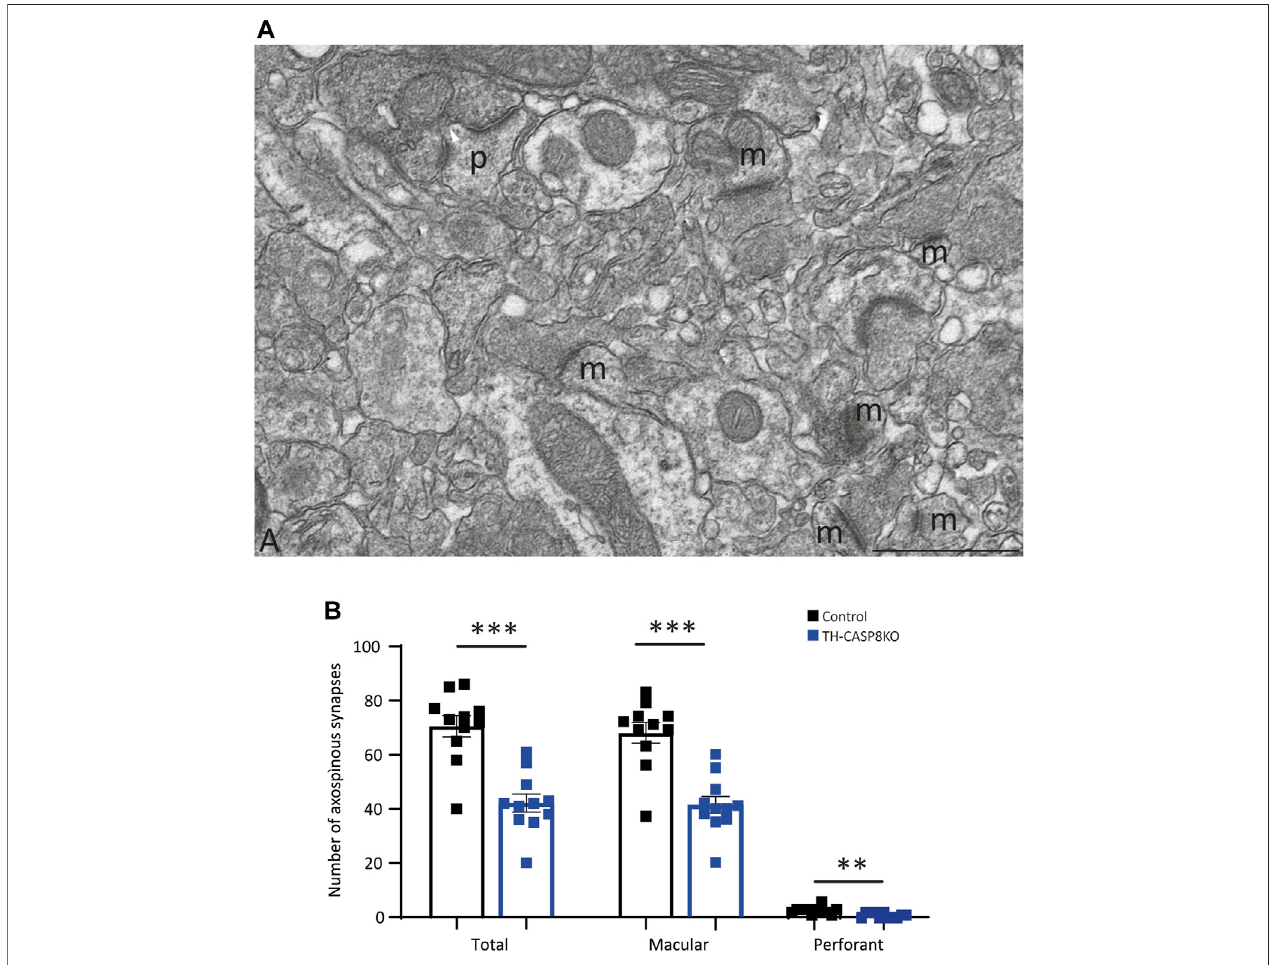
FIGURE 4 | Synapse types in the striatum. (A) Microphotograph of a region of 17.7 µm 2 taken from one of the striatum mosaics used for counting axospinous synapses. Two types of axospinous synapses were found: (i) the most abundant were the macular synapses characterized by a dense, continue and straight postsynaptic membrane (m), and (ii) the perforated synapses in which the central zone of the postsynaptic membrane loses its thickening and invaginates within the presynapticterminal(p).Scalebar=1 µm. (B) QuantitativeanalysisshowsthatthenumberofstriatalaxospinoussynapseswashigherinthecontrolthanintheTH- CASP8KO mice. T, total number of synapses, M, number of macular synapses. P, number of perforated synapses, **, p < 0.01; ***, p < 0.001.